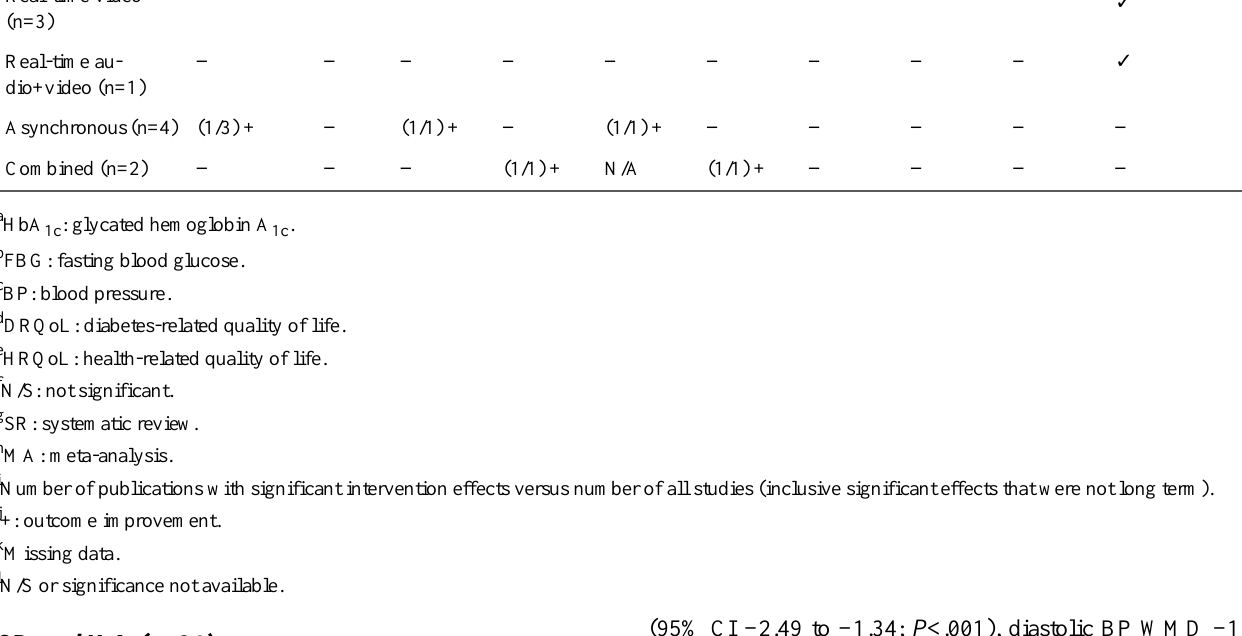
ableTime-sav- N/S f or signifi- cance not avail-